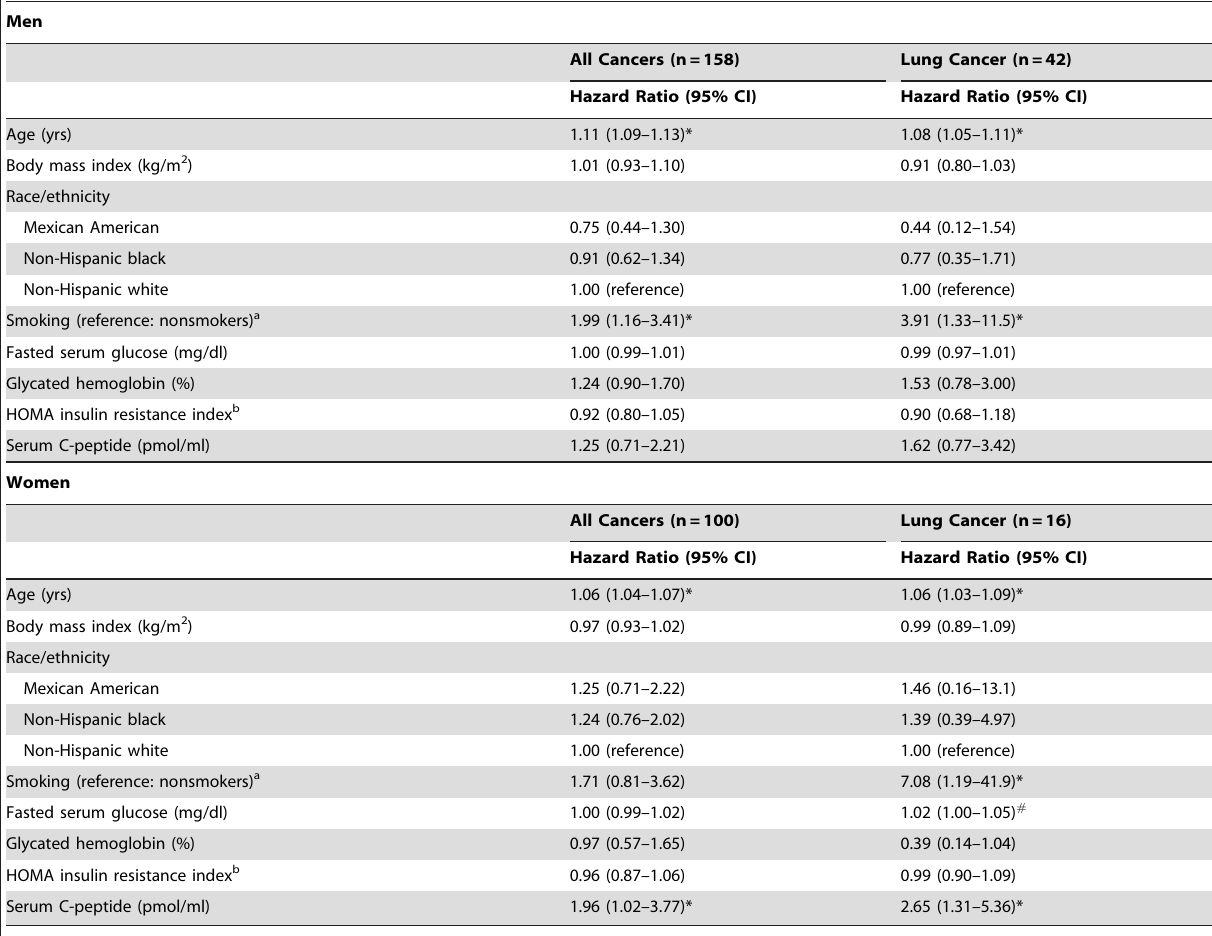
Table 2. Cancer mortality analysis of risk factors associated with all-cause and lung